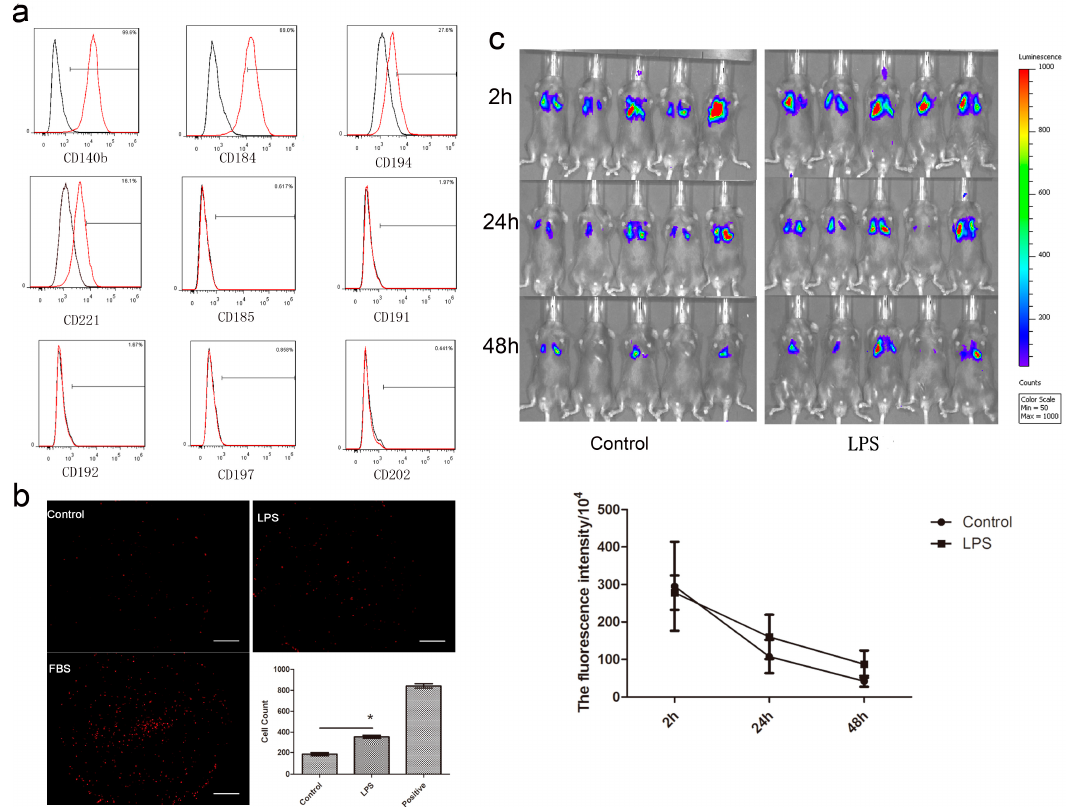
Figure 2. Migration of MenSCs in vitro and in vivo. ( a ) MenSC Surface markers for migration. The black lines represent the isotype control and the red lines represent the levels of the surface markers; ( b ) Migration of MenSCs assessed using the transwell system. After migration, MenSCs adhered to the underside of the membrane were stained with Dil and counted under the fluorescence microscopy. The summative histograms are shown; ( c ) Migration of MenSCs to the lung of mice. MenSCs were allowed to migrate in the mice for three days and observed using a live imaging system ( upper panel) at 2, 24 and 48 h, after which the fluorescence intensity was measured ( lower panel). Three independent experiments with similar results were performed. * p < 0.05. Scale bar: 1000 µm.